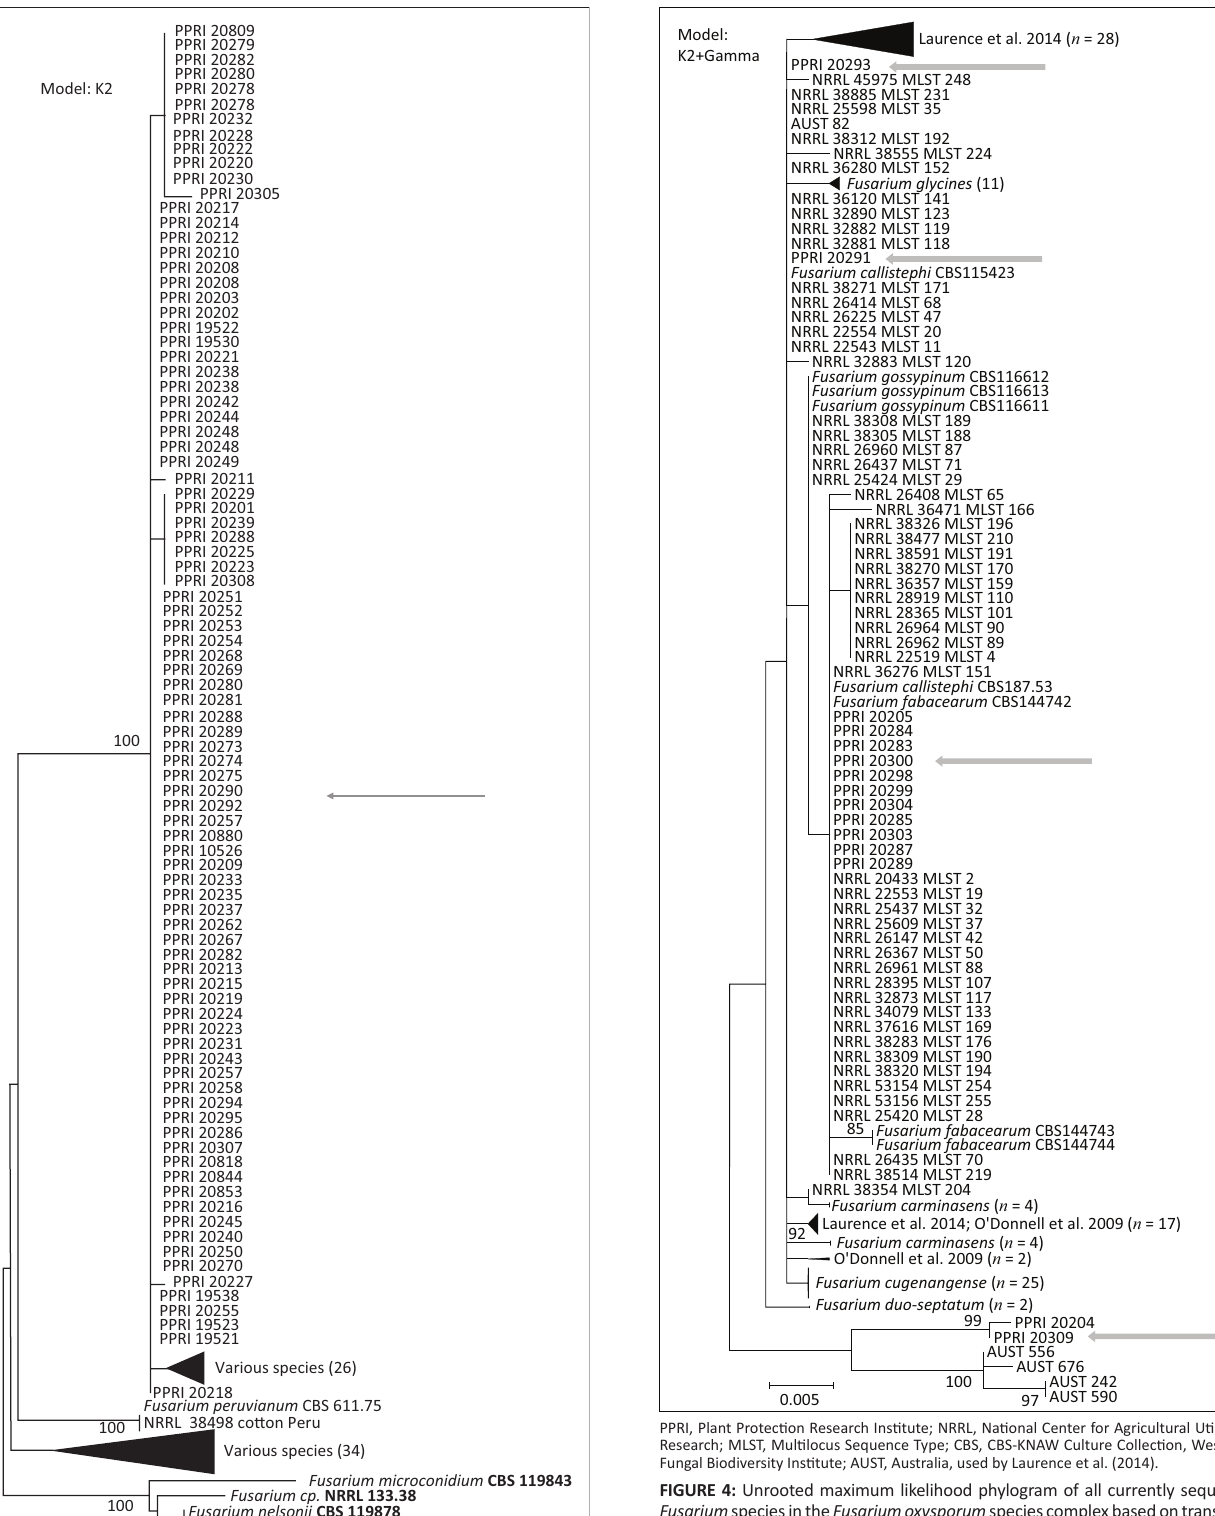
FIGURE 4: Unrooted maximum likelihood phylogram of all currently sequenced Fusarium species in the Fusarium oxysporum species complex based on translation elongation factor 1-a gene sequences. Bootstrap support values higher than 80 % are shown on the branches. The evolutionary model applied to the analysis is indicated on the figure. Isolates from this study are indicated with PPRI